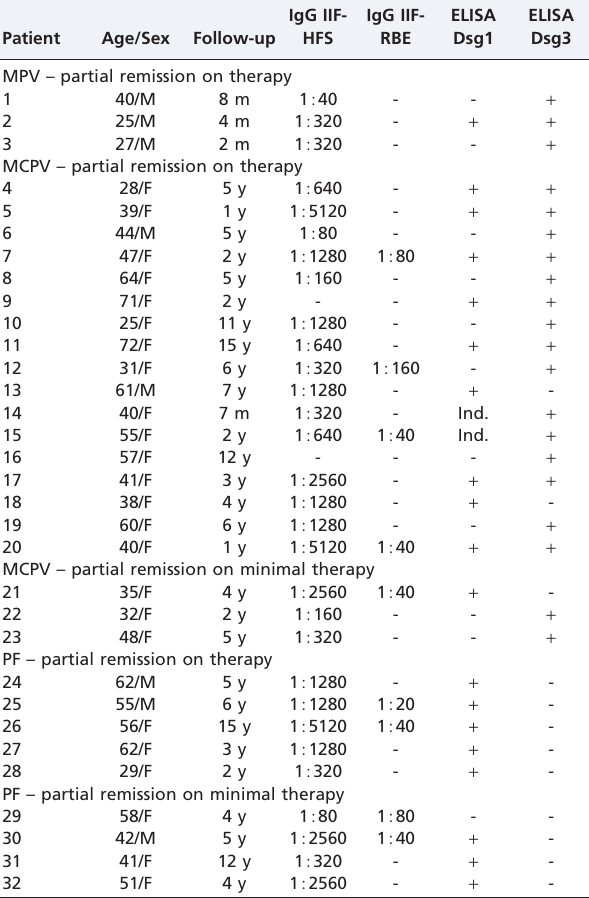
Table 2 - Clinical and immunological profile of pemphigus patients.